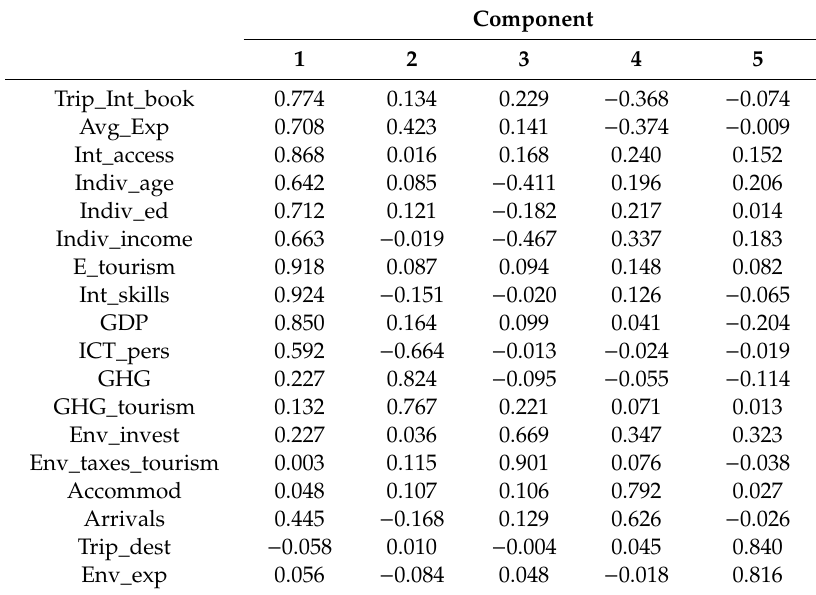
Figure 4. Component plot in rotated space. Source: Authors’ own contribution, based on data provided by EUROSTAT. Table 4. Rotated component matrix a .